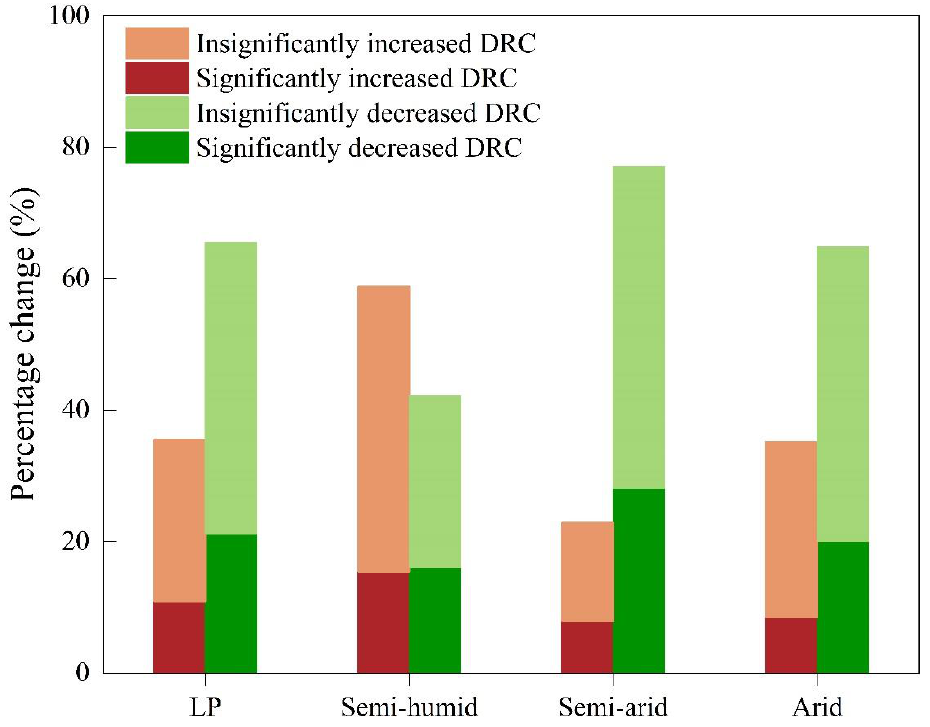
Figure 5. The percentage of area with different DRC (Drought Resistance Coefficient) change characteristic (Insignificantly/Significantly increased/decreased) on the whole LP and three climate zones (semi-humid, semi-arid, arid).